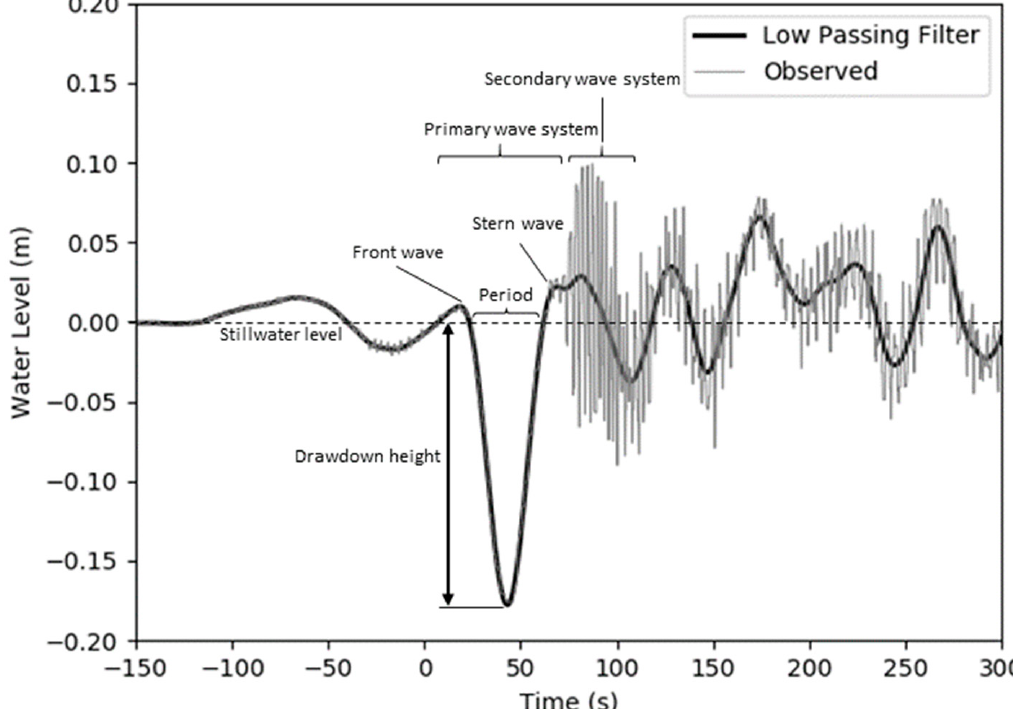
Figure 1. A typically recorded wave system during a ship passage illustrating the terminology used in this paper. Time equal zero indicates when the ship passes in front of the measuring station. The grey line displays the actual water level measurements, whereas the thick black line shows the water level after a low-pass filter has been applied.